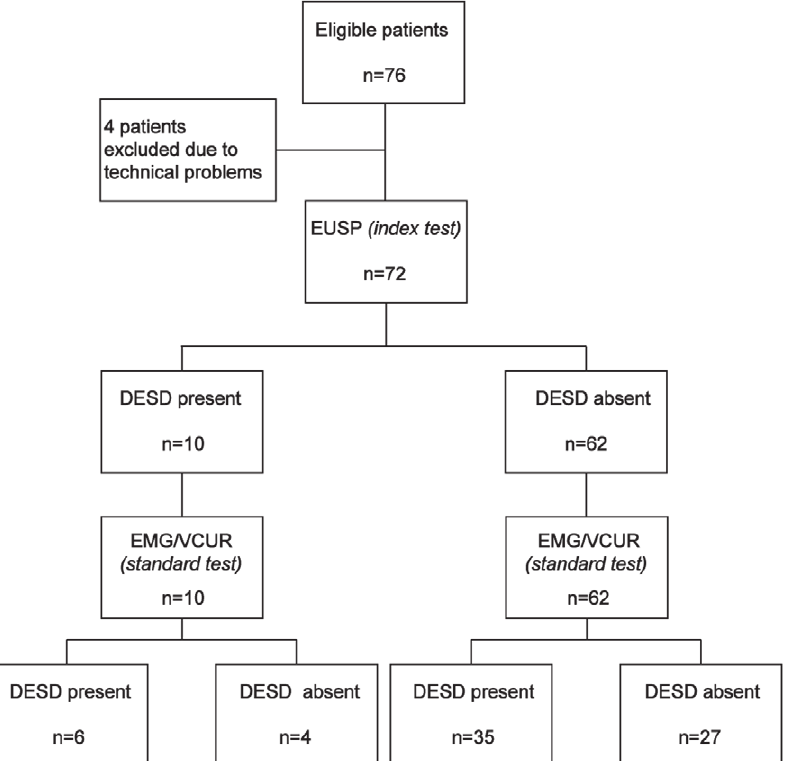
Figure 2. Standards for Reporting of Diagnostic Accuracy flow diagram. [8] Comparison of external urethral sphincter pressure (EUSP) measurement (index test) versus combined pelvic floor electromyography (EMG) and videocystourethrography (VCUR) (reference standard) for the diagnosis of detrusor external sphincter dyssynergia (DESD). doi:10.1371/journal.pone.0037996.g002 PLoS ONE |